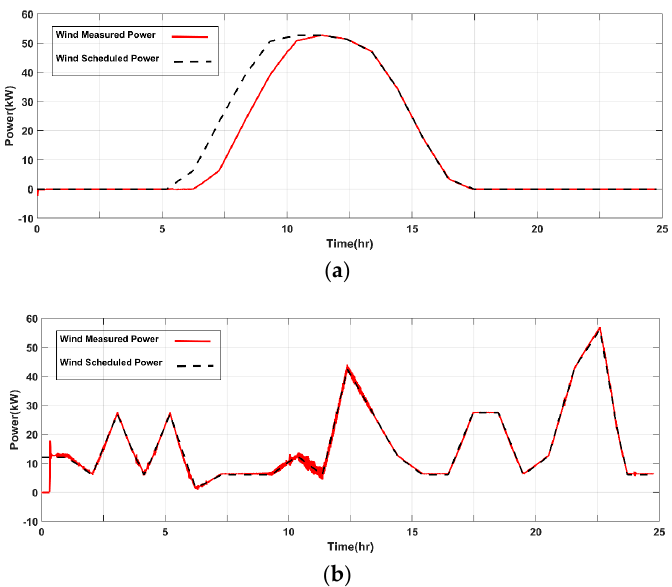
Figure 10. ( a , b ) The scheduled and measured generation profiles for PV and WT, respectively.